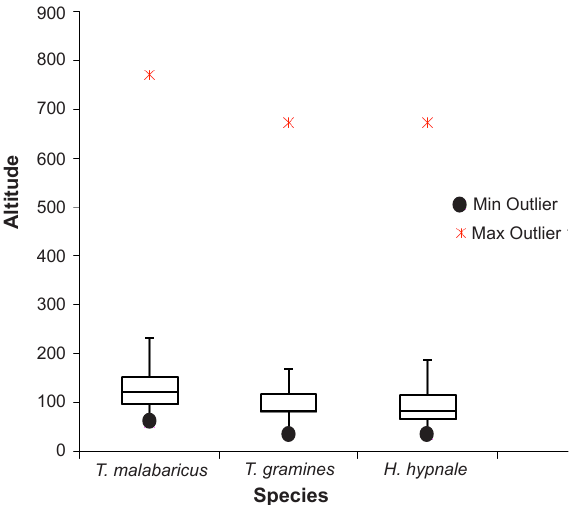
Table 2. List of forest types preferred by the pit vipers Forest types